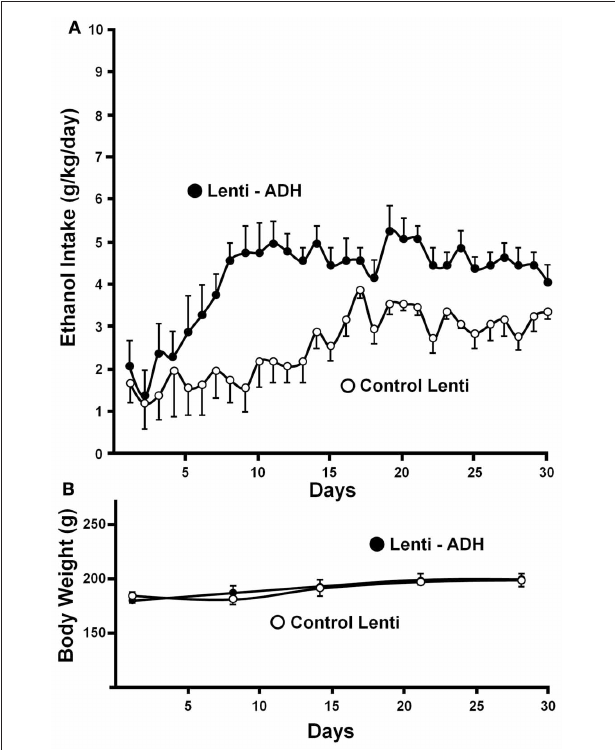
FIGURE 5 | Administration of the alcohol dehydrogenase coding gene (rat liver adh ) into the VTA increases voluntary alcohol intake in rats (UChB) bred as alcohol drinkers. (A) Four days after the injection of the lentiviral vectors, animals were allowed free availability of 5% (v/v) ethanol and water. Rats significantly ( p < 0 . 001) increased their alcohol intake when injected with a lentiviral vector encoding alcohol dehydrogenase(rADH) (Lenti-ADH) into the ventral tegmental area compared to that observed after treatment with an empty lentiviral vector (control-Lenti) (A) . (B) No differences in body weight were observed along the experiment in Lenti-ADH-treated rats vs. control-Lenti virus-treated rats. Abscissa: days of ethanol availability. (From Karahanian et al., 2011).